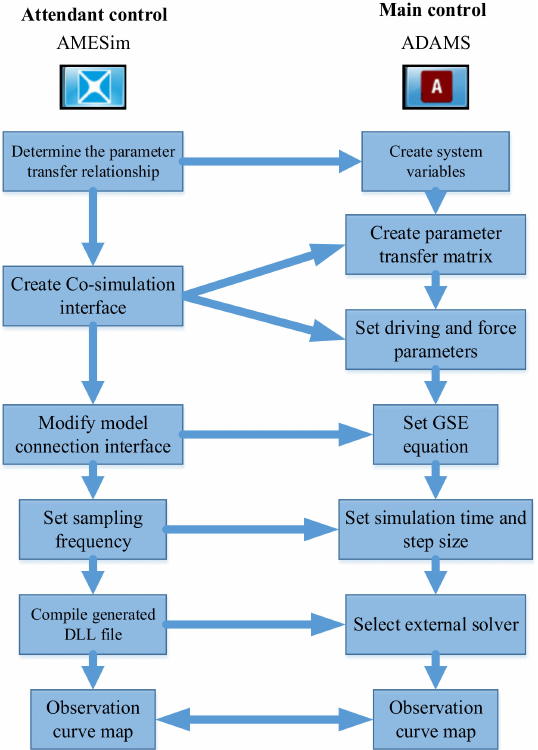
Figure 11. Parameter transfer relationship between AMESim and ADAMS (the specific flow of co-simulation).